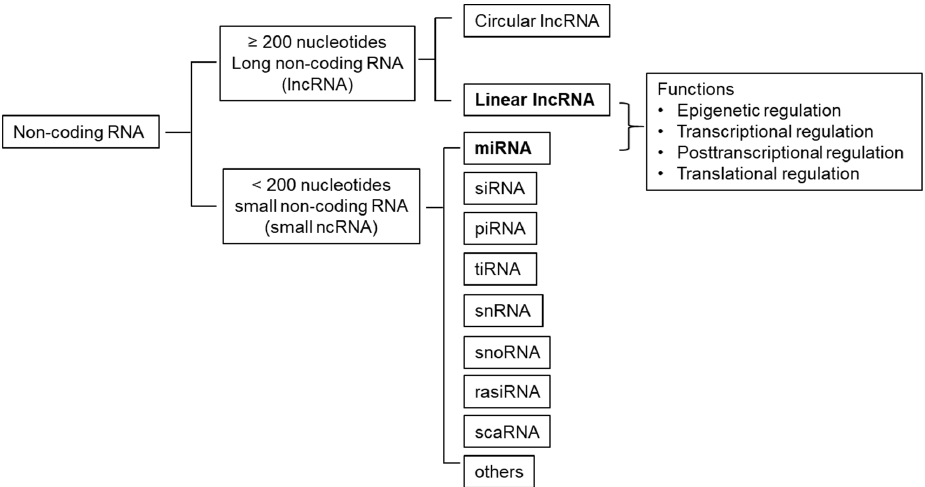
Figure 1. Classifications of non-coding RNA (ncRNA), including long non-coding RNA (circular and linear lncRNA) and small non-coding RNA (microRNA (miRNA), small interfering RNA (siRNA), piwi-interacting RNA (piRNA), transfer RNA-derived stress-induced small siRNA (tiRNA), small non-coding RNA (snRNA), small nucelolar RNA (snoRNA), small cajal body-specific RNA (scaRNA), and others). The functions of lncRNA and miRNA can be epigenetically, transcriptionally, and post-transcriptionally regulated.